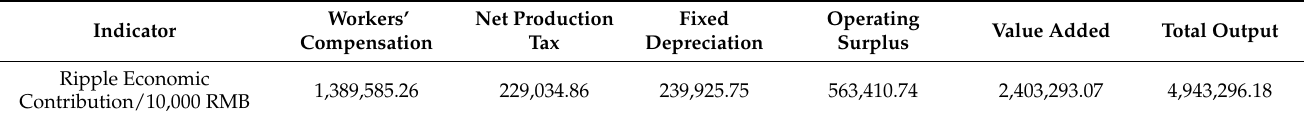
Table 5. Ripple economic contribution of Xiamen Port to the city in